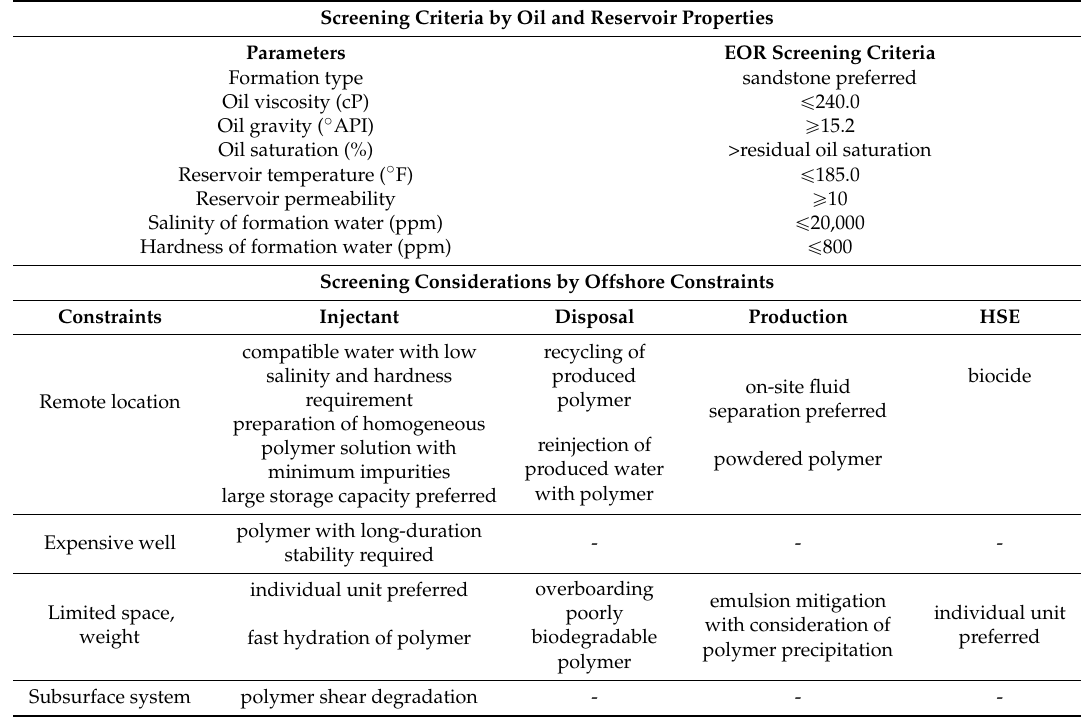
Table 8. New screening criteria for the polymer